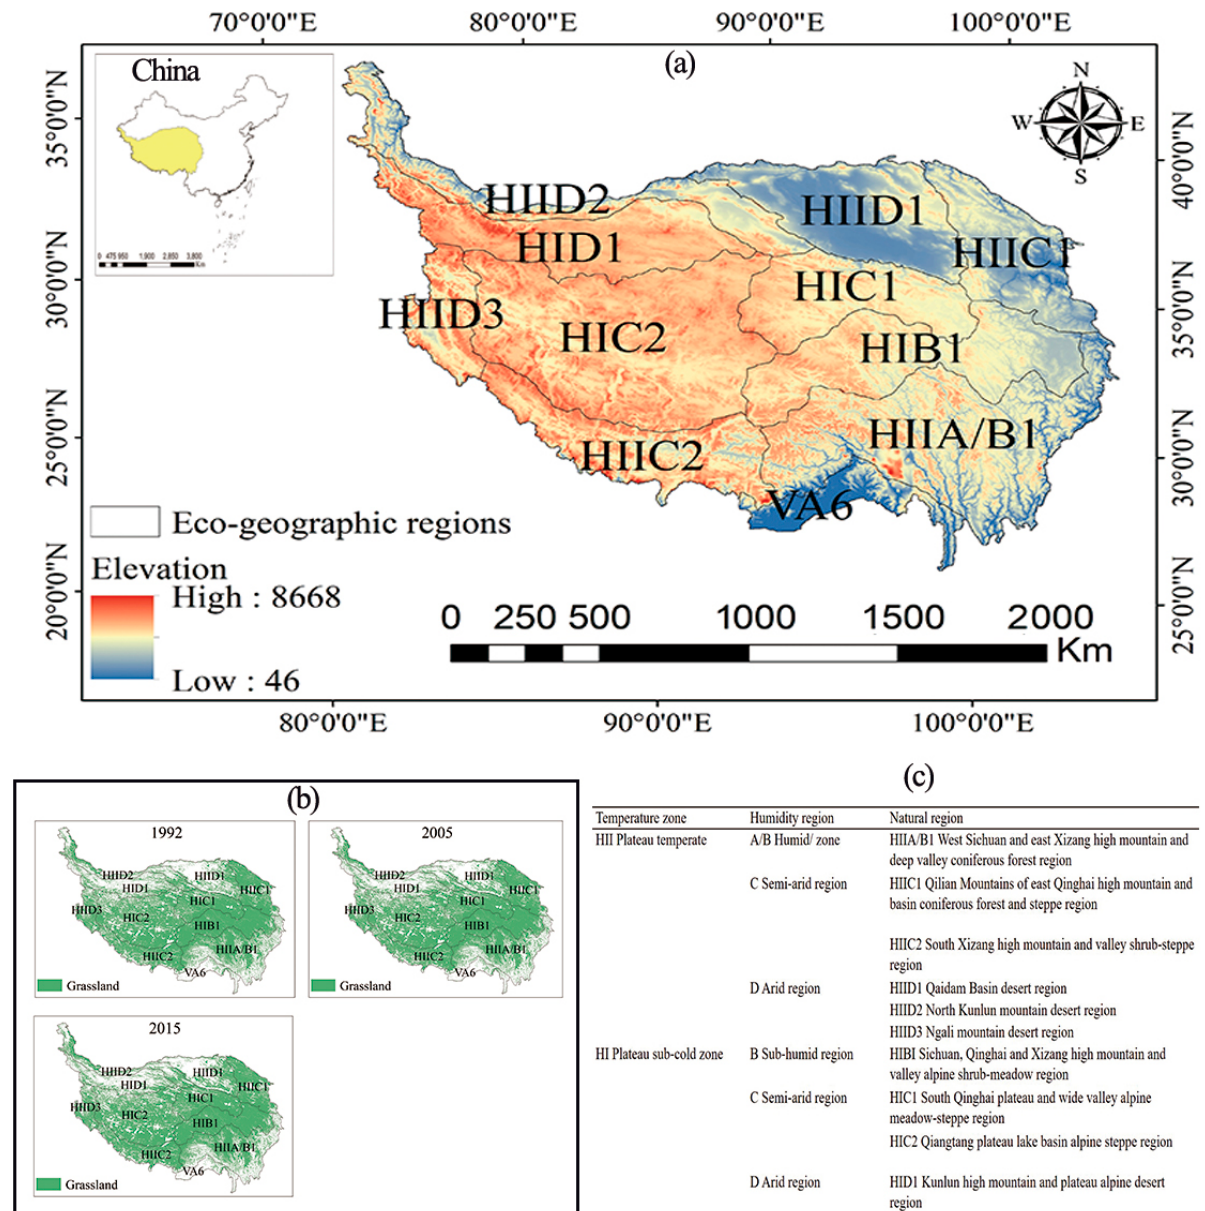
Figure 1. The location of the TP and spatial distribution of eco-geographic regions and grasslands. ( a ) Location of the Tibetan Plateau in China; ( b ) distribution patterns of grasslands on the Tibetan Plateau in 1992, 2005, and 2015; ( c ) ecogeographic divisions summarized in the